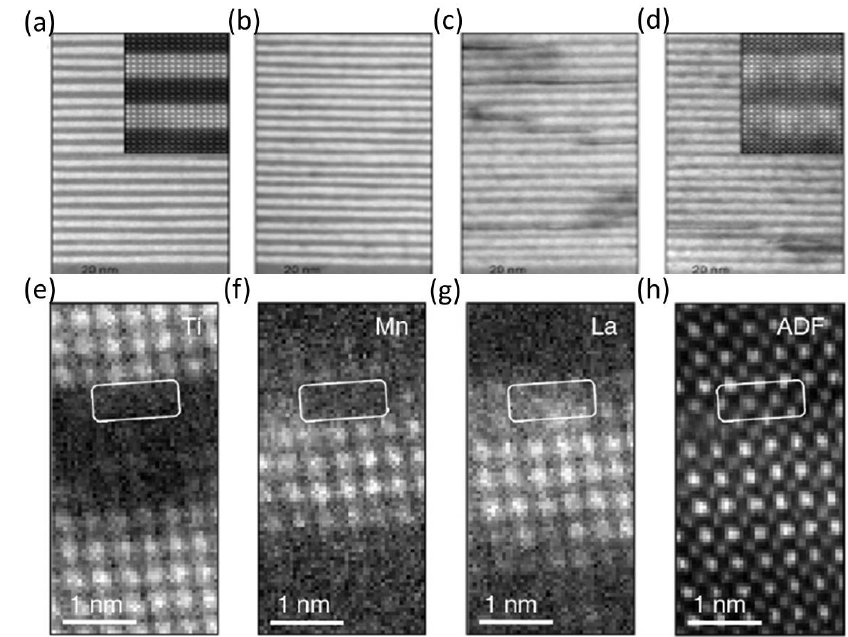
Figure 14. Annular dark field image of the cross-section of (La 0.7 Sr 0.3 MnO 3 ) 5 /(SrTiO 3 ) 5 superlattices grown at different laser spot size ( a ) 10.2, ( b ) 7.5, ( c ) 5 and ( d ) 1.6 mm 2 . The laser energy during growth was fixed at 35 mJ. ( e – g ) are the elemental mapping of ( e ) Ti, ( f ) Mn, and ( g ) La for LSMO grown at a laser spot size of 1.6 mm 2 . ( h ) Simultaneously recorded annular dark field image. Figures are adapted from Ref. [50].